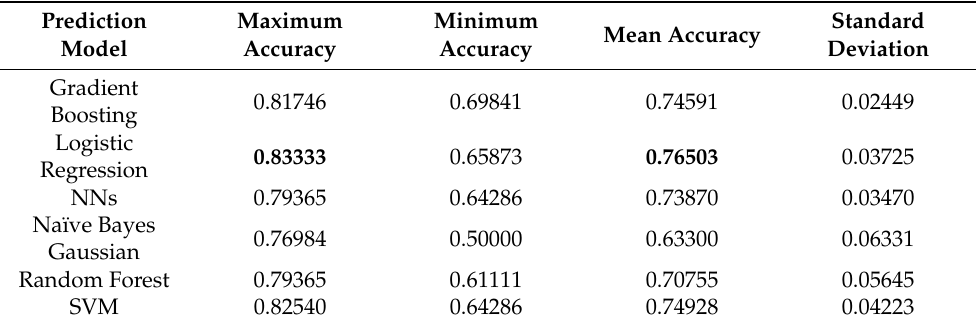
Table 8. Maximum, minimum, and mean accuracy of prediction models over the tested set for the left and right legs combined. The best results are indicated with